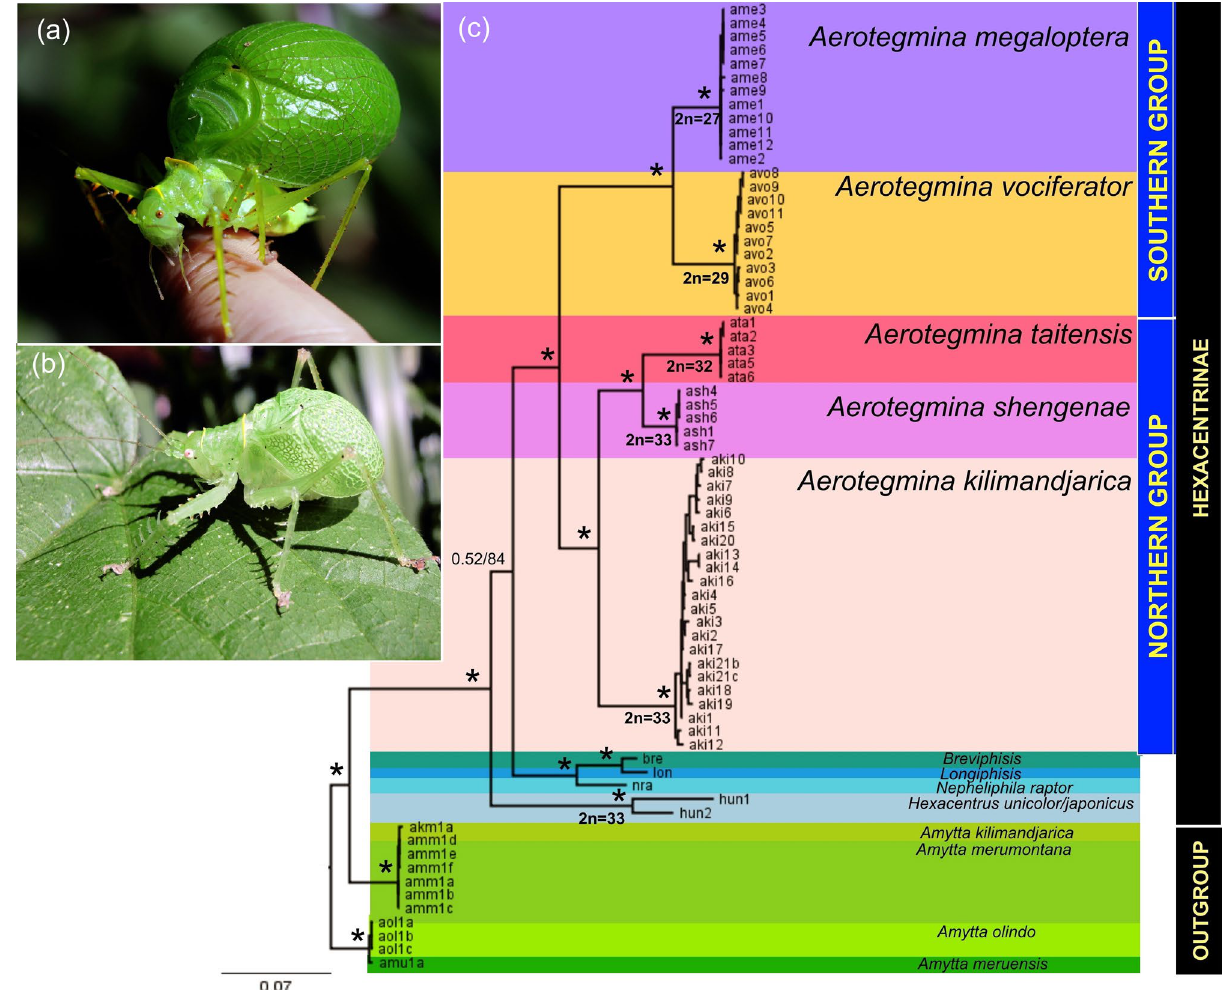
Figure 2. Aerotegmina megaloptera ( a ), A. shengenae ( b ), photo C. Hemp. Bayesian inference tree from a dataset including COI, 16S, and H3 sequences of Hexacentrinae genera ( c ). Bayesian (BI) and Maximum likelihood (ML) topologies were consistent, so only one tree is shown. Values at nodes correspond to posterior probability/bootstrap support; *designates ≤ 0.99 and 95% values for BI and ML, respectively. Diploid chromosome numbers for Aerotegmina species are plotted on the phylogenetic tree. Scale bar: number of substitutions per nucleotide position. OUT—outgroup,